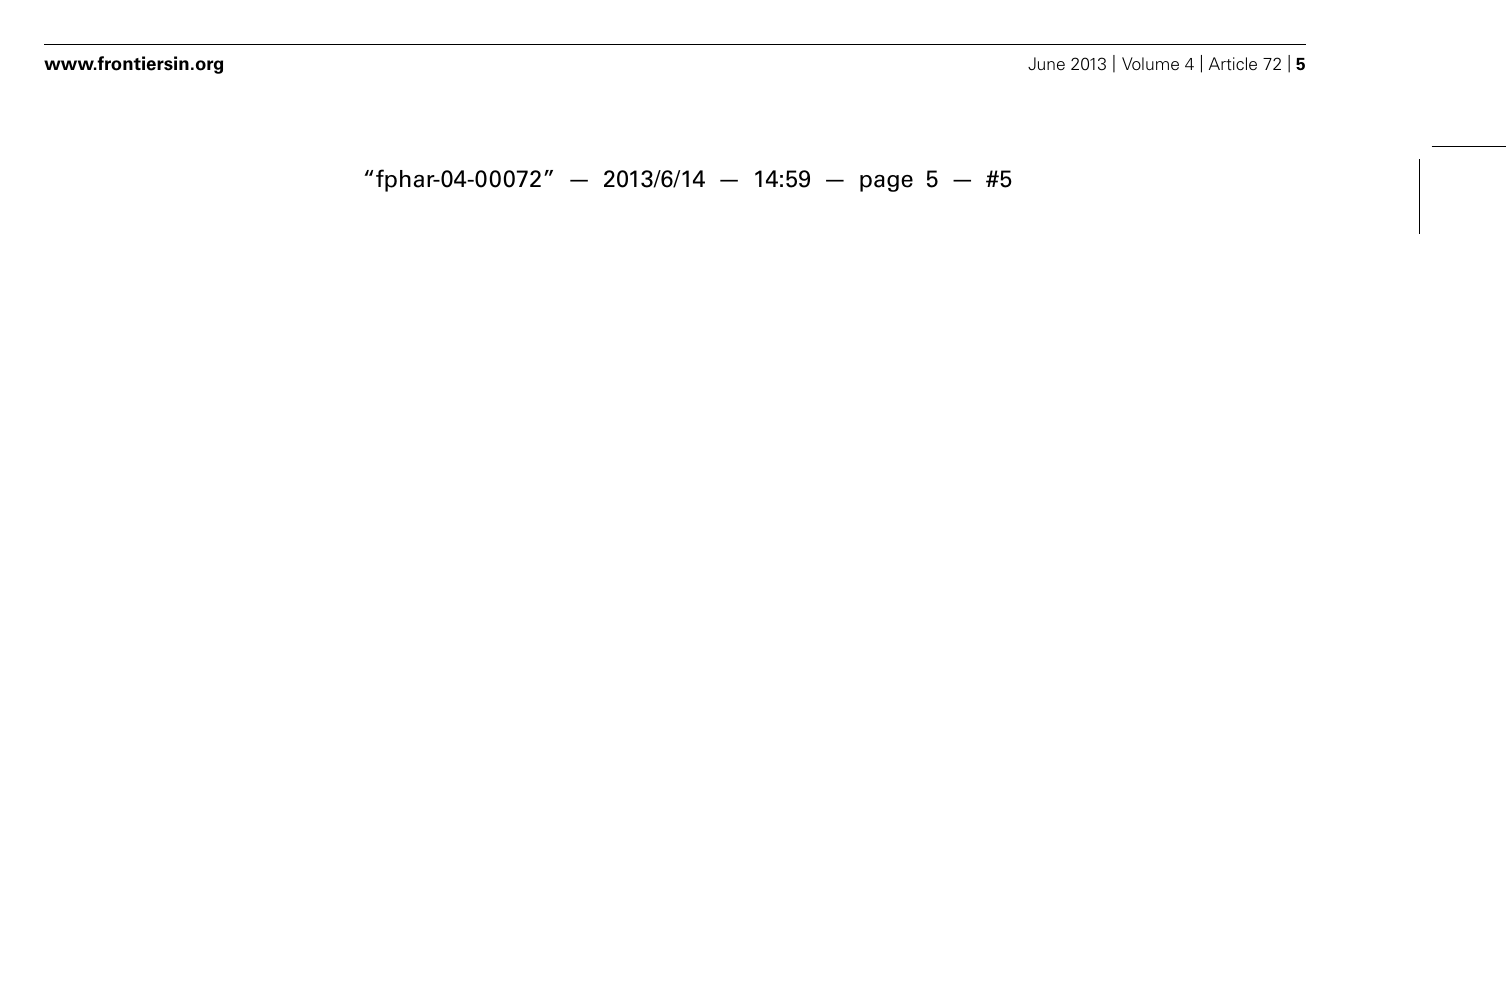
FIGURE 4 |Time-frequency decomposition of representative hippocampal recordings from two mice treated with vehicle (A,B) or semagacestat (100 mg/kg; C,D) approximately 30 min after start of recordings as indicated by white arrows. Note the strong and persistent